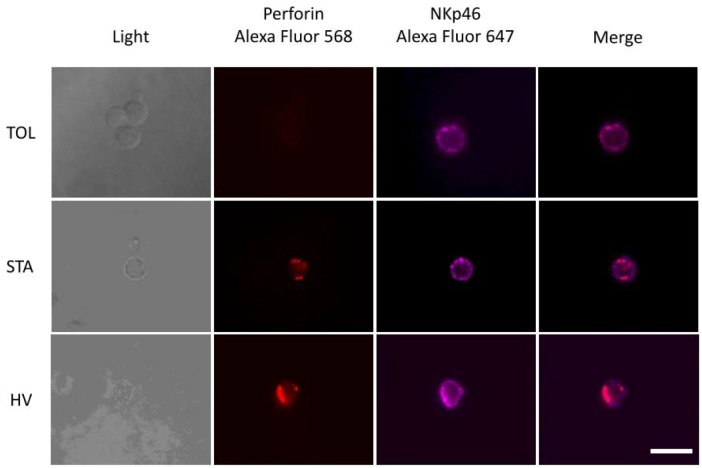
Microscopic analysis of perforin and NKp46 expression. Perforin and NKp46 expression were analyzed following 5 h coculture of peripheral blood mononuclear cells (PBMC) with 221 cell lines. Images were captured by using EVOS systems with light (Left) and fluorescent detectors perforin (AF568), NKp46 (Cy5), or an overlay of all fluorescent channels (Right). Examples are shown for one tolerant patient (TOL) (top), one stable patient (STA) (middle), and one healthy volunteer (HV) (bottom). NK cells were activated following the spontaneous lysis assay protocol and then labeled with anti-perforin-Alexa Fluor 568 and anti-NKp46-Alexa Fluor 647.